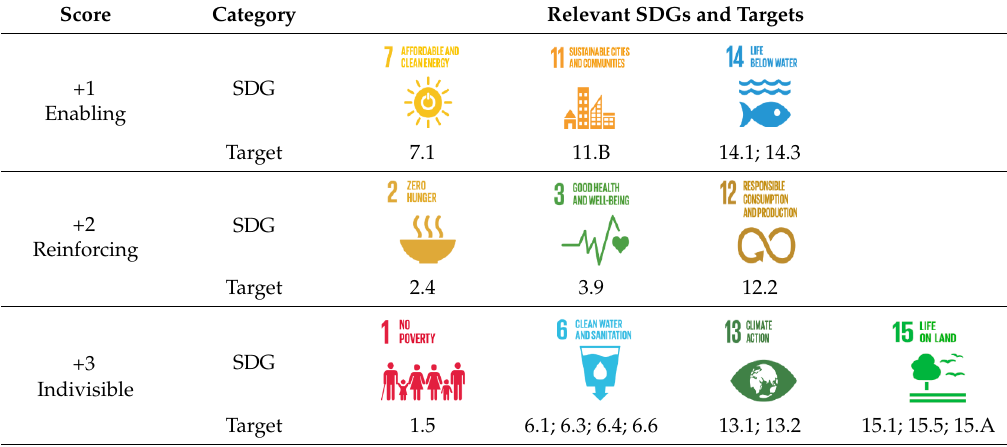
Table 1. Positive interactions between the United Nations Sustainable Development Goals (SDGs) and their targets and Swedish wetland ecosystems. Description of SDGs and targets are taken from UN’s 2030 Agenda [28].